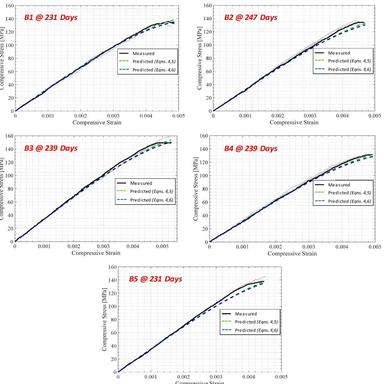
Compressive stress–strain relationships of the five tested NP-UHPC mixes.